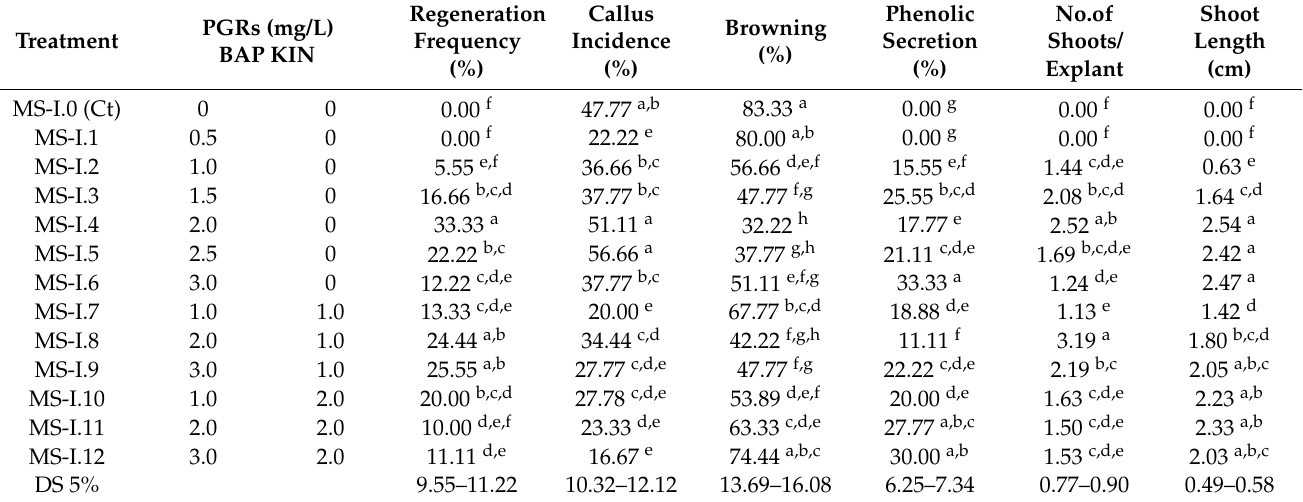
Figure 2. P. quadrangularis nodal segments cultured in vitro to induce organogenesis: ( a ) Vertically initiated explant; ( b ) Horizontally initiated explant; ( c ) Longitudinal section of the adventitious shoot. ( a , b ) Scale bar represents 1 cm; c- Scale bar represents 100 µm. Table 4. Cytokinin influence on axillary shooting in P. quadrangularis (the first stage of initiation).